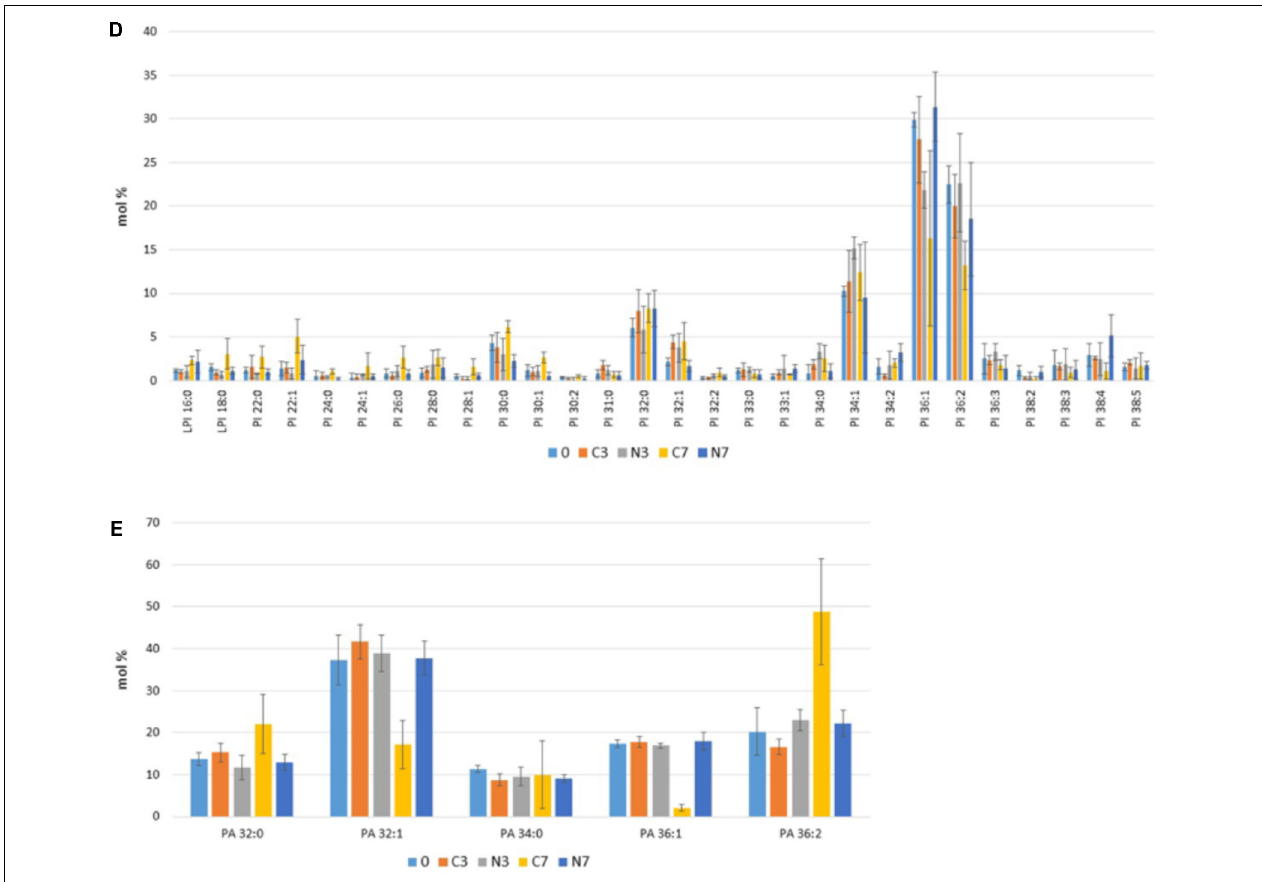
FIGURE 5 | Molecular species of (A) phosphatidylcholine (PC), (B) phosphatidylethanolamine (PE), (C) phosphatidylserine (PS), (D) phosphatidylinositol (PI) and (E) phosphatidic acid (PA) detected in bovine raw milk samples (M1, M2, and M3) (in mol%) at the initial stage (0) and after 3 and 7 days in cold- stored while N 2 -flushed milk (N3, N7) compared to the only cold-stored controls (C3,